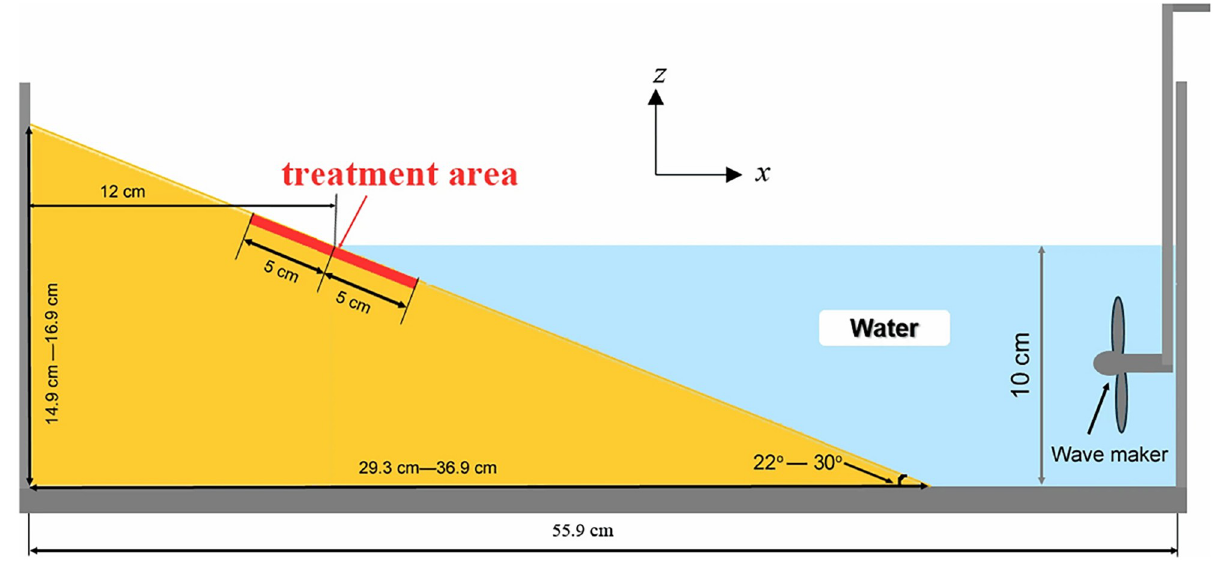
Fig 9. Coastal dune erosion